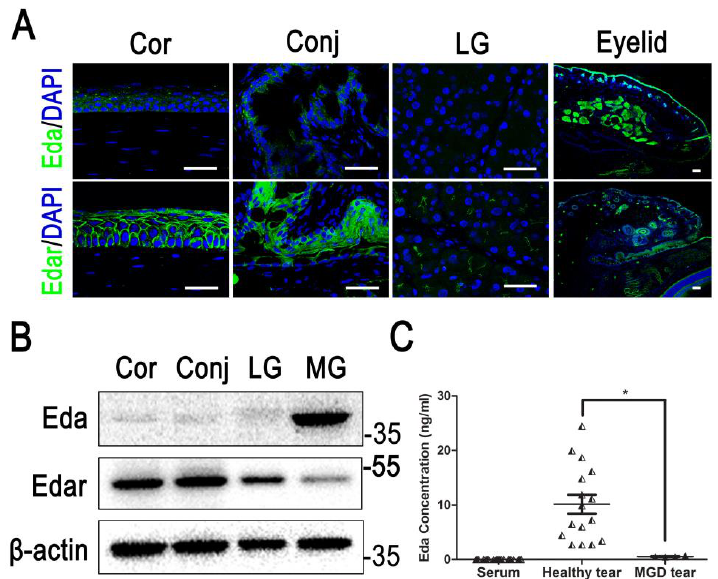
Figure 2. The expression of EDA-EDAR in the ocular surface [33]. ( A ) Immunofluorescent staining of EDA and EDAR expression in the corneal (Cor) and conjunctival (Conj) epithelium, lacrimal gland (LG) and meibomian gland (MG). (Scale bars represent 50 µ m). ( B ) Western blot results of EDA and EDAR in corneal epithelium, conjunctiva, lacrimal gland and meibomian gland tissues. ( C ) ELISA results of EDA in normal human serum, healthy human tear and tears from MGD patients (* p < 0.05). (Reproduced from Ref. [33] ).